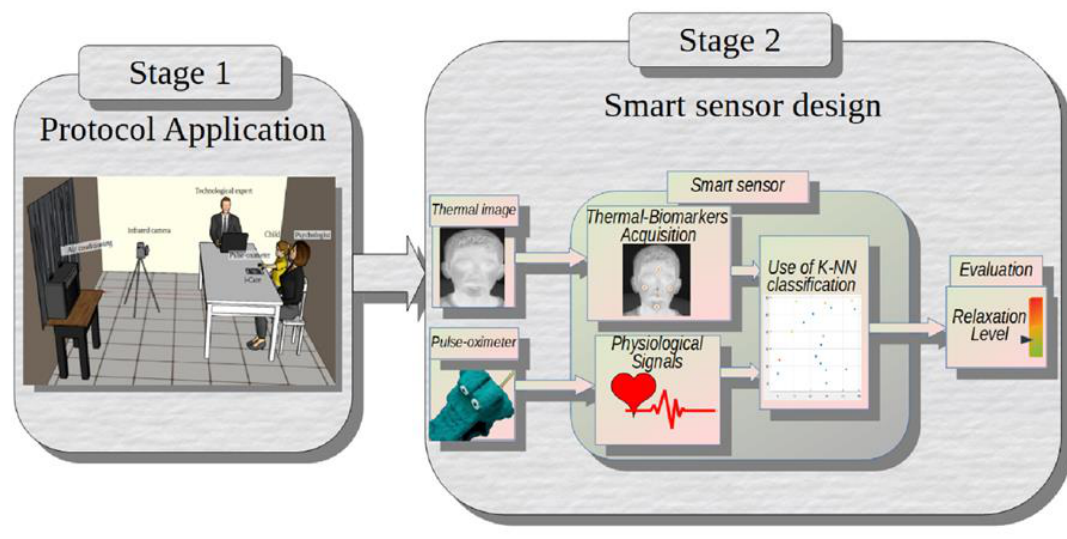
Figure 1. General methodology.